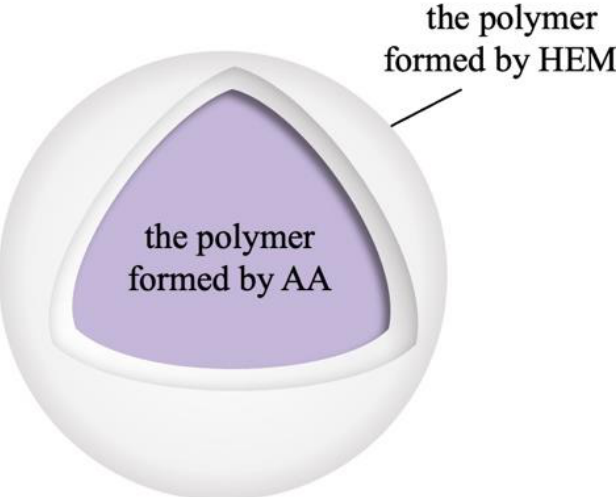
Figure 5. Core–shell structure of the hydroxyl-type waterborne acrylic acid dispersion Figure 5. Core – shell structure of the hydroxyl-type waterborne acrylic acid dispersion particles.